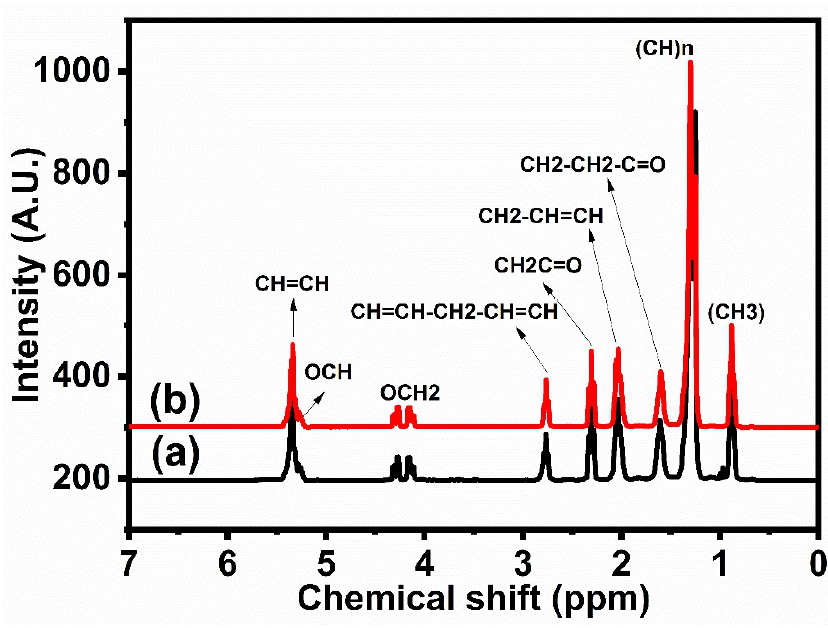
Figure 6. 1 H-NMR spectra of ( a ) refined cooking oil and ( b ) waste cooking oil.